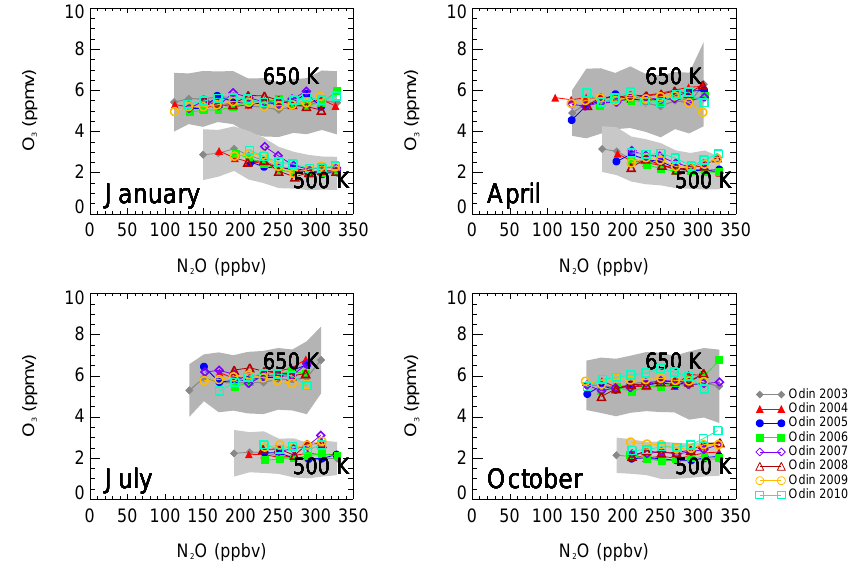
Fig. 3. Comparison of monthly averages of O 3 and N 2 O derived from Odin/SMR for the years 2004 (red triangles), 2005 (blue circles), 2006 (green squares), 2007 (purple diamonds), 2008 (dark red triangles), 2009 (gold circles) and 2010 (green squares) with monthly averages derived for the year 2003 (grey diamonds) at 500 ± 25K and 650 ± 25K. Shown are the monthly averages for the Northern Hemisphere tropics (0–30 ◦ N) for the months January, April, July, and October. The grey shaded area marks the range of standard deviations of the monthly averages of O 3 derived from Odin/SMR data for the year 2003.